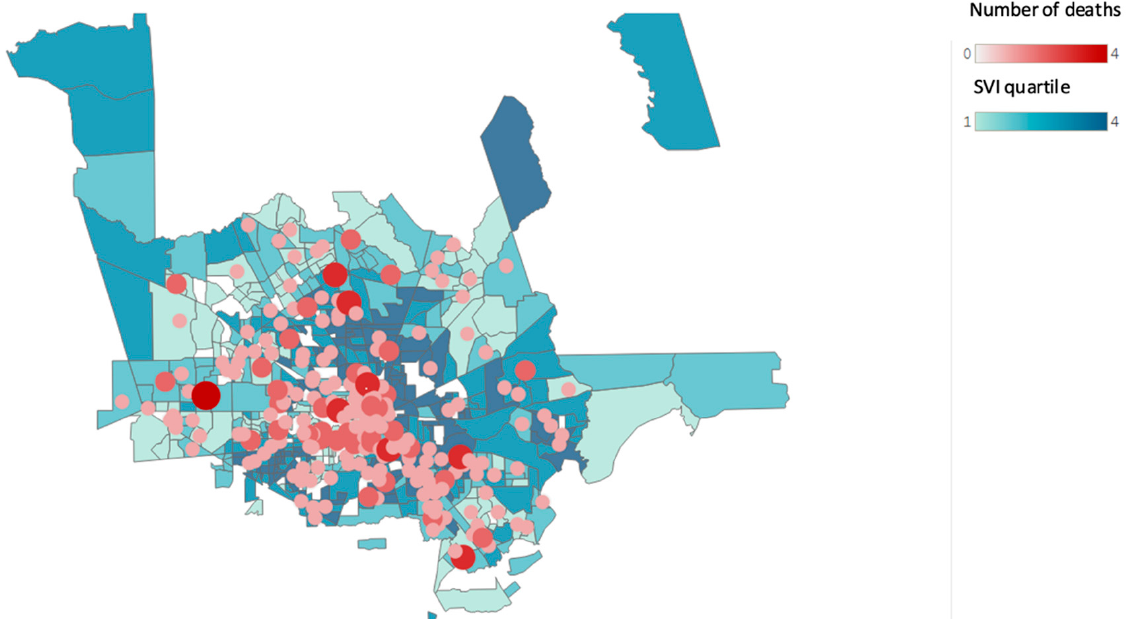
Figure 2. Non-hospital opioid-related overdose deaths and Social Vulnerability Index (SVI)